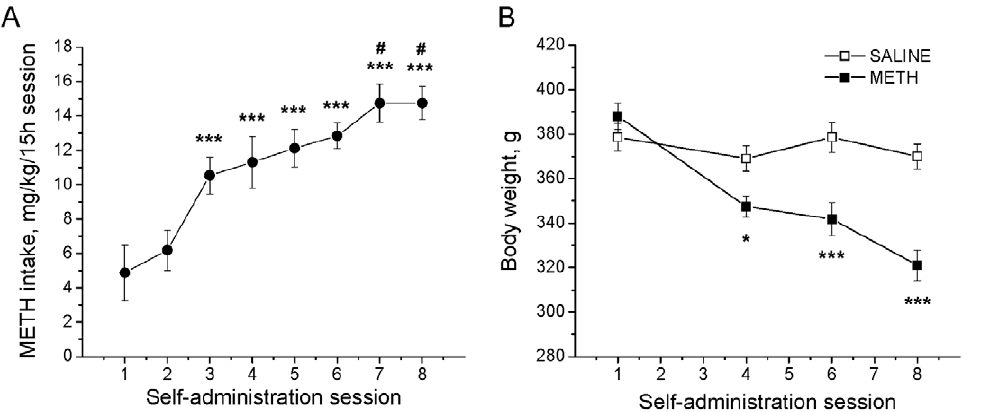
Figure 1. Changes in METH intake and body weight over the course of self-administration in rats. (A) Escalation of METH intake in rats. Symbols indicate average daily amount of actively self-administered METH during each of 8 consecutive daily sessions (means 6 SEM; n=11). Rats increased METH intake on days 3–8 compared with days 1 and 2, and days 7–8 showed further increases in intake compared with day 3. Data analyzed by one-way ANOVA for repeated measures, followed by Tukey’s multiple comparison test: *** p , 0.001 in comparison with sessions 1 and 2, # p , 0.05 in comparison with session 3. (B) METH caused significant decreases in body weight in the animals that actively self-administered the drug (means 6 SEM; n=9). Data analyzed by two-way ANOVA for repeated measures, followed by Tukey’s multiple comparison test: * p , 0.05; *** p , 0.001 in comparison to saline group.